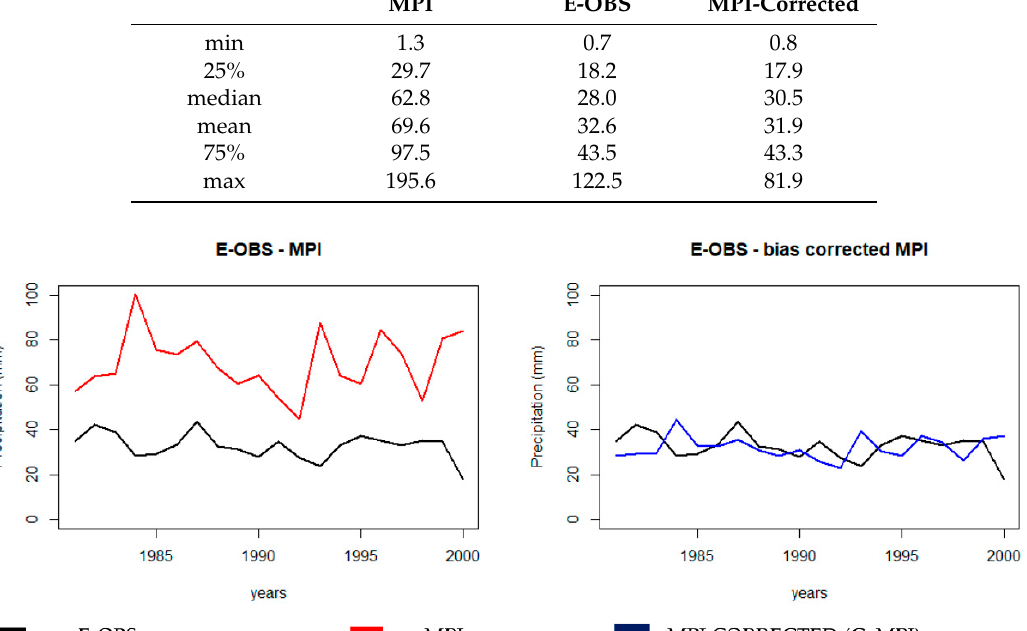
Table 4. Statistical analysis of the results temporally. For the estimation found in the table, the mean precipitation of all grid points monthly was firstly calculated before the statistical components of these data series were used for the table. MPI E-OBS MPI E-OBS MPI-Corrected